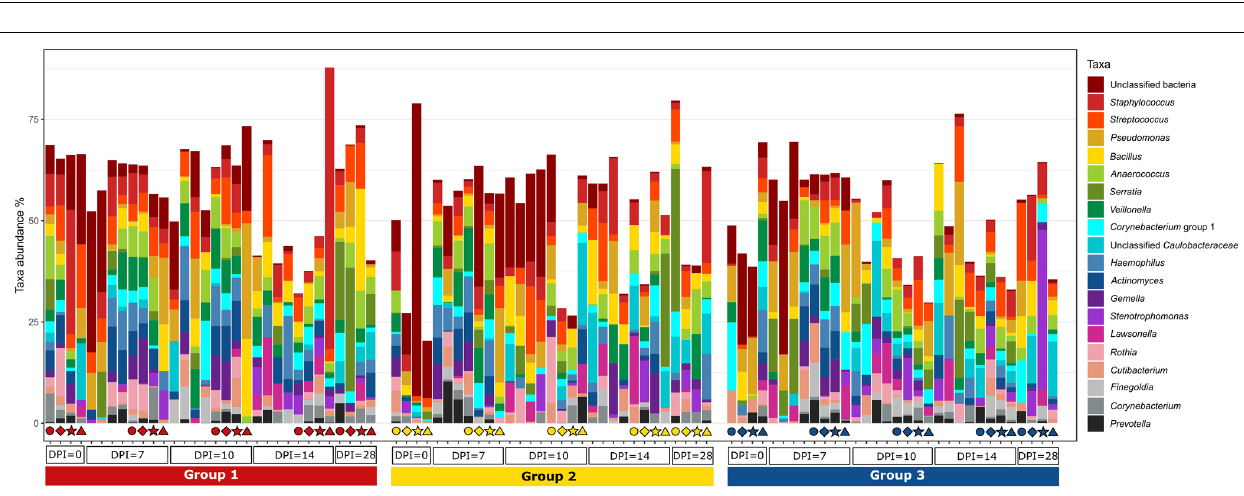
FIGURE 8 | Relative amount (%) of the most abundant bacterial genera present in the blood at different days post H. meleagridis infection (0, 7, 10, 14, and 28 dpi). Samples are divided by group. Group 1, infected with H. meleagridis + lux -tagged E. coli ; Group 2, infected with lux -tagged E. coli ; Group 3, negative control. The same four birds from each group were sampled at 0, 7, 10, 14, and 28 dpi. Each of these birds in a group is shown by a unique symbol (circle, diamond, star, or triangle) and has different color for each dpi. By following each symbol and color, the microbial composition of that particular bird at different sampling points can be evaluated. In addition, blood from birds killed at 7, 10, 14, and 28 dpi (without any symbols) were also